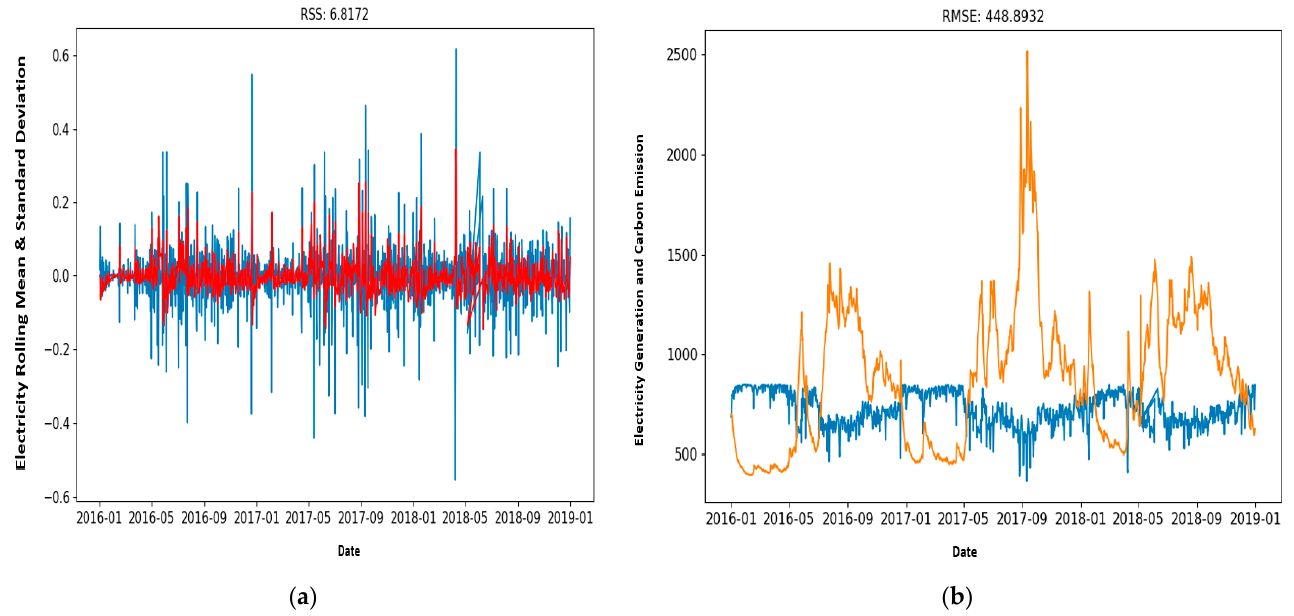
Figure 7. Test results: ( a ) autoregressive moving average RSS values for ARIMA when combined and ( b ) autoregressive moving average RMSE values for ARIMA.